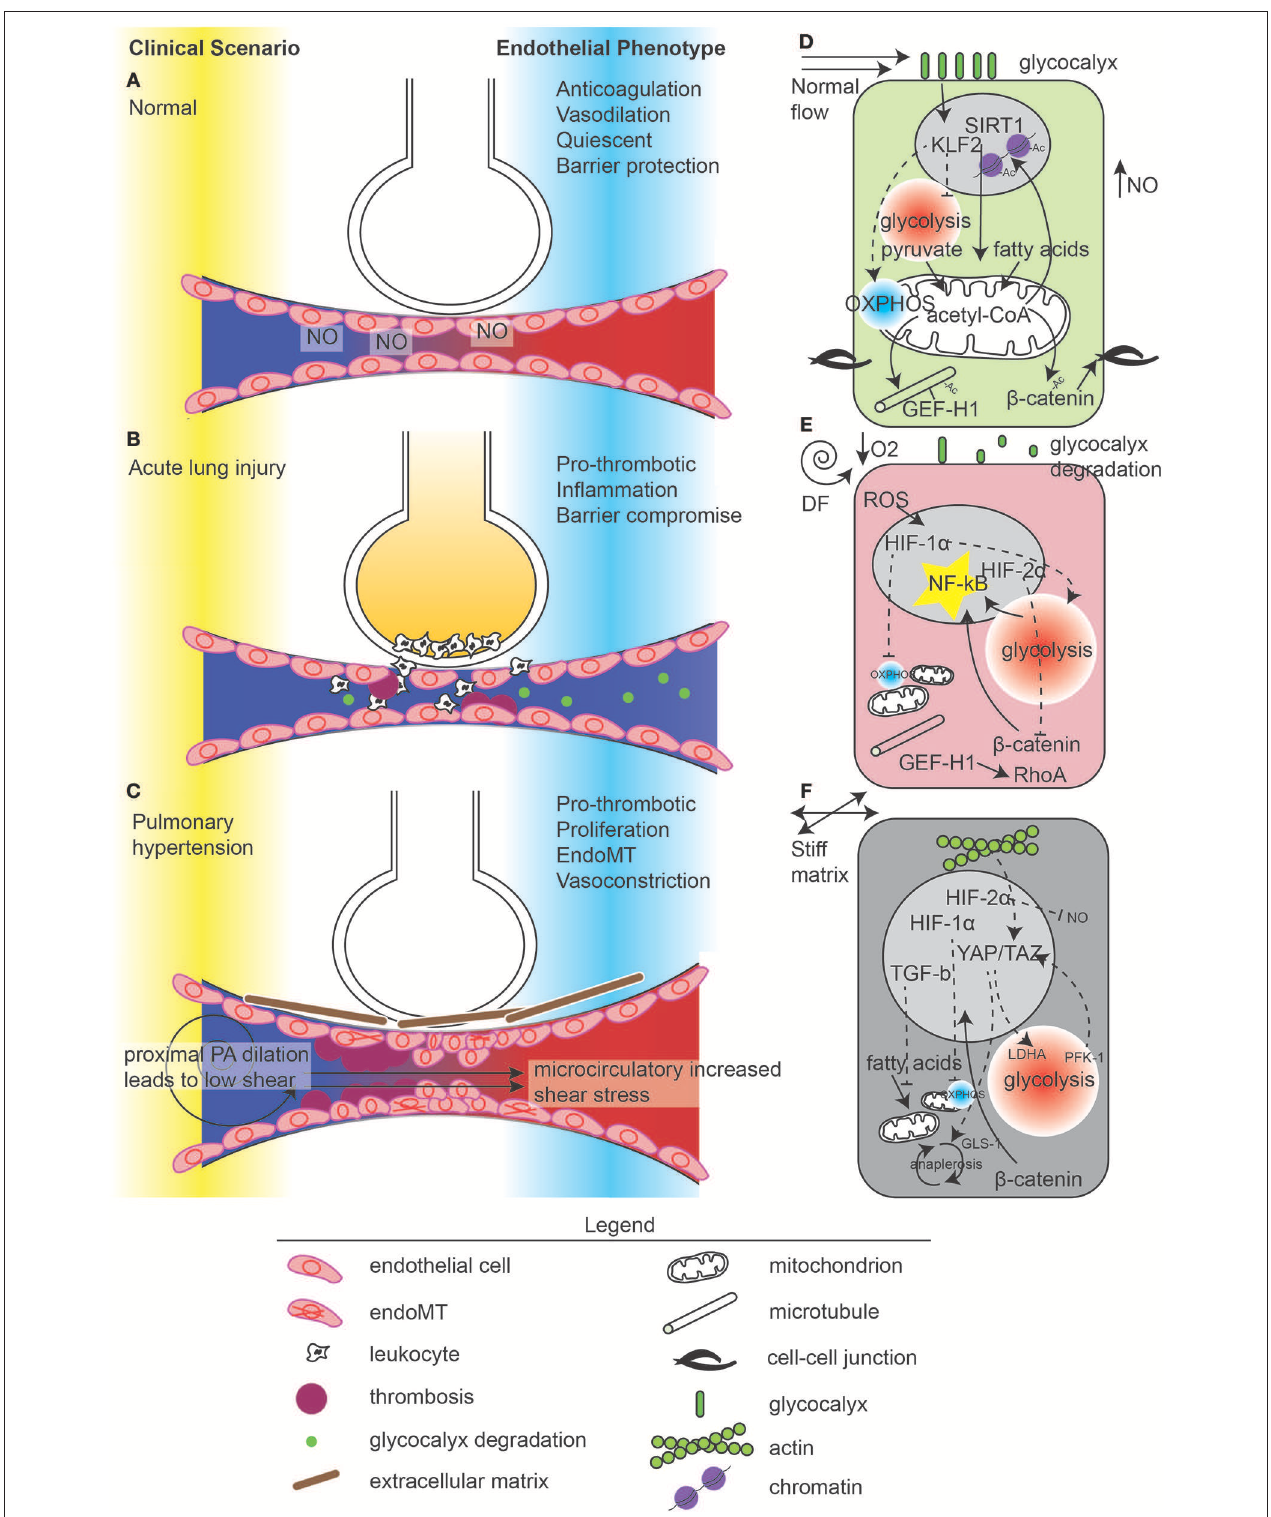
FIGURE 1 | Mechanometabolomic coupling to disease states in the lung.Vascular disease states in the lung in (A) normal, (B) acute lung injury, and (C) pulmonary hypertension. In normal states, ventilation through the alveoli and perfusion occur through nitric oxide (NO) release by the endothelium. Normal